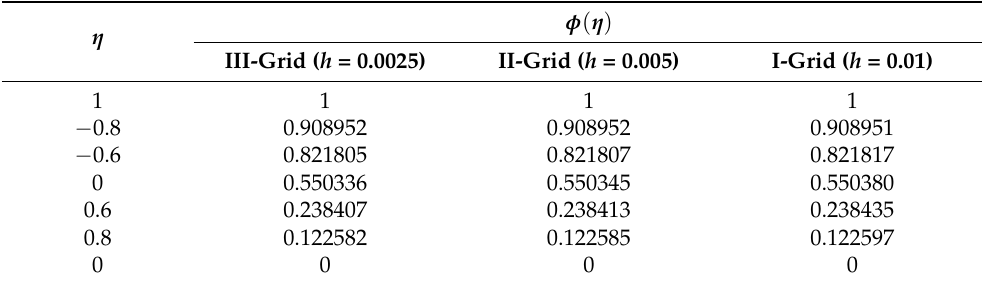
Table 2. Non-dimensional values of concentration φ ( η ) on three grid sizes for Re = 6, M 0 = 2,